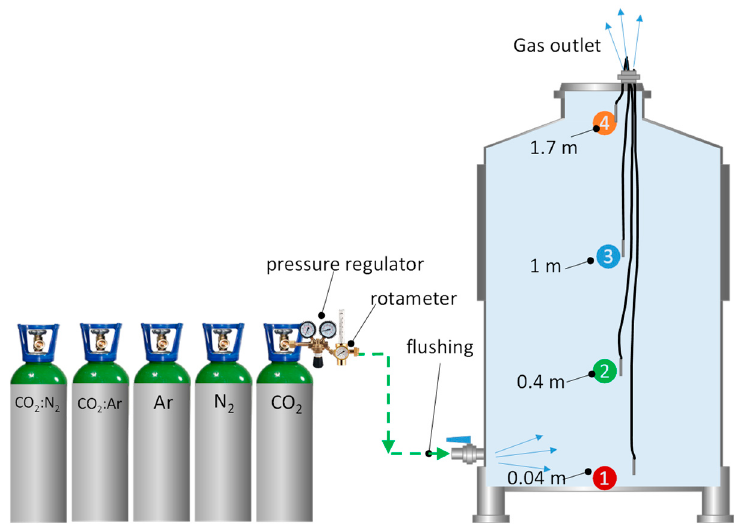
Figure 1. Schematic diagram of the monitoring system for total and sequential inerting in an empty tank to compare the different inert gases (Purging), as well as the different probes placed at different heights.